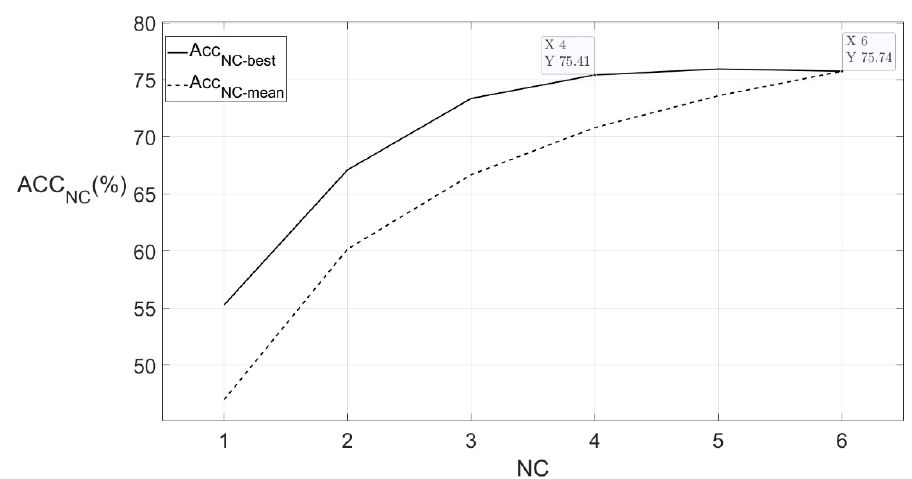
Figure 8. Relation between Acc NC-best , Acc NC-mean, and NC. NC is the number of channels. For each NC, we listed all possible channel combinations of NC channels and constructed a new dataset for each combination by only adopting features from channels in the combination. For each combination, after performing the random forest algorithm, we could get an accuracy. The highest one among the accuracies was marked as Acc NC-best and the mean value of the accuracies was marked as Acc NC-mean . The figure shows the trend of Acc NC-best and Acc NC-mean changed as the NC changed.